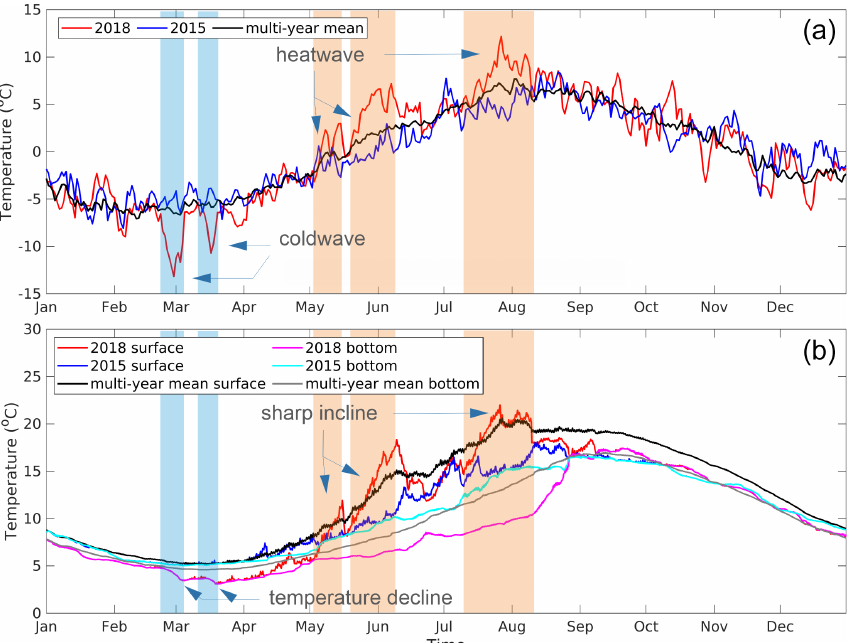
Figure 5. (a) Annual variation in the simulated air temperature (with the multiyear mean removed) at NSB III for 2018 (red line), 2015 (blue line) and the multiyear mean (black line). In the warm season of 2018, the periods in which the air temperature was higher than the multiyear mean and the SST increased are delineated with orange frames. Likewise, in the early spring of 2018, the periods in which the air temperature was lower than the multiyear mean and the SST decreased are delineated with blue frames. (b) Similar to (a) but for the simulated water temperature at the surface and the